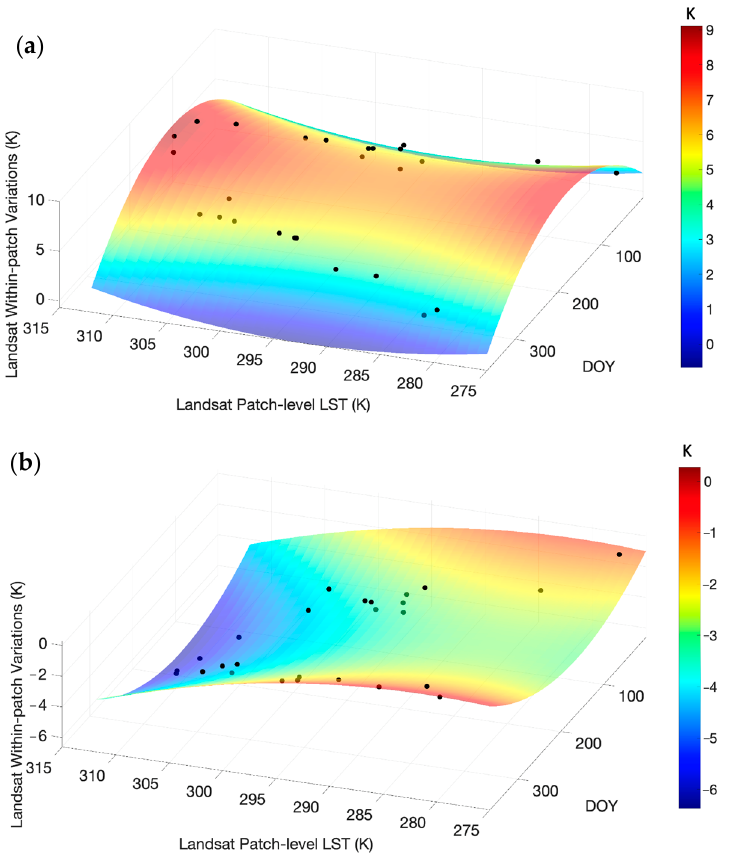
Figure 8. Comparison of modeled within patch temperature variation (pixel LST—patch mean LST) for an urban pixel ( a ) and a rural pixel ( b ). Curved surfaces: EOFRV predictions; black dots: Landsat observations.